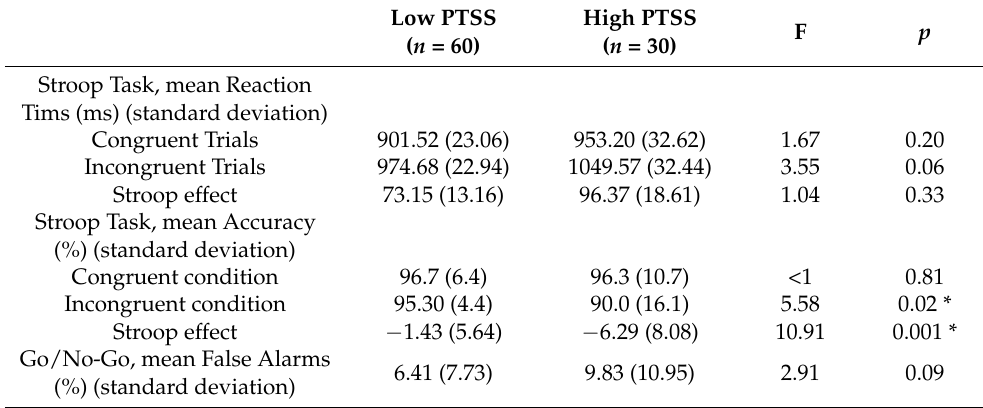
Table 3. Mean ( ± SD) of reaction times and accuracy in the Stroop task and Go/No-Go task for the two groups of